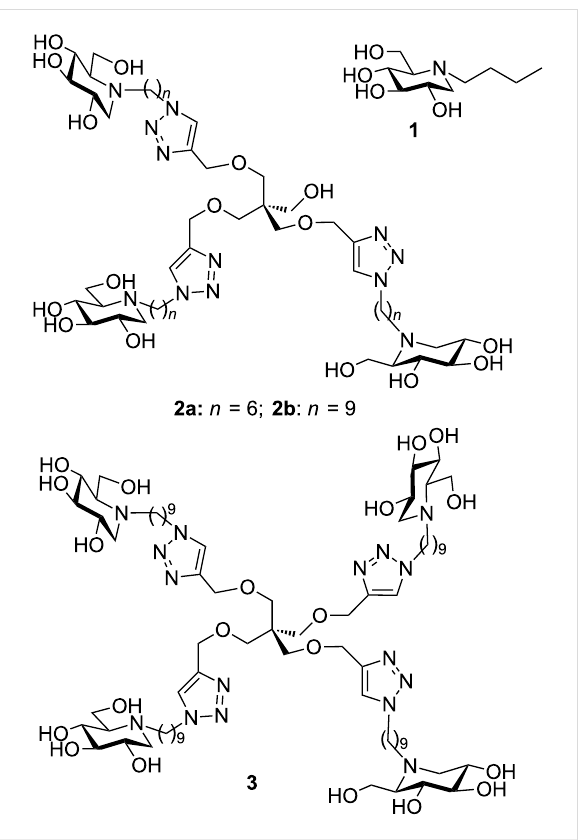
Figure 1: N -Bu DNJ ( 1 ) and examples of potent multivalent pharmaco- logical chaperones and CFTR correctors ( 2 and 3 ).